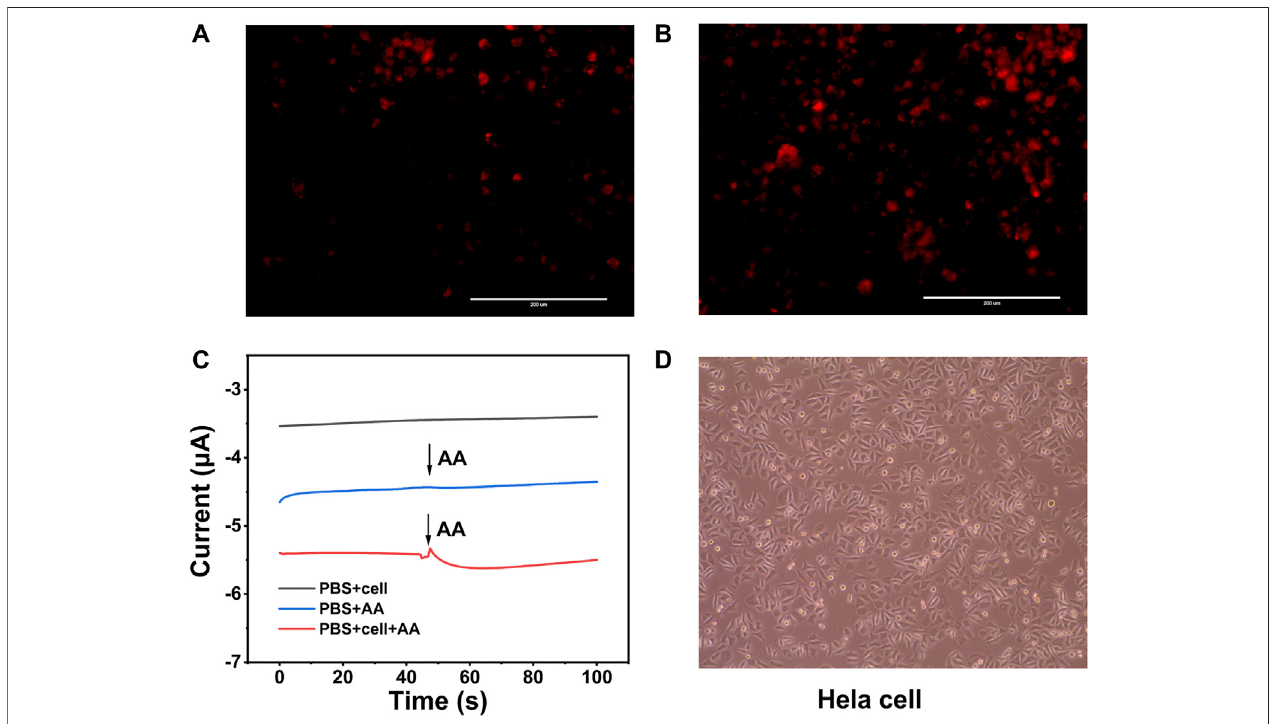
FIGURE 5 | (A) DHE fl uorescence image of Hela cells without stimulation by AA (400 μ M). (B) Hela cells stimulated by AA (400 μ M). (C) Current responses of Hela cells without and with AA (400 μ M) stimulations at an applied potential of − 0.5 V. (D) Bright images of Hela cells after electrochemical detection.